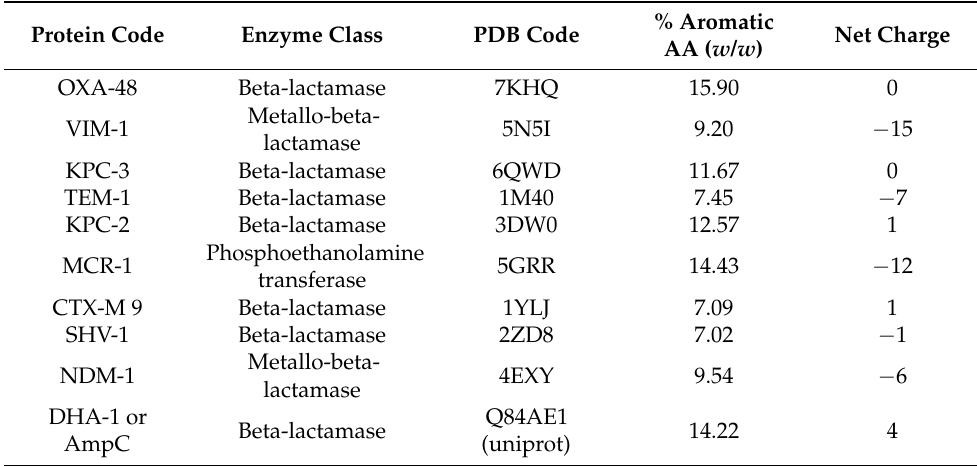
Table 4. Classes, percentages of aromatic amino acids, and net charges of the resistance enzymes indicated to be expressed by the studied MDR strains of E. coli and K. pneumoniae . Protein Code Enzyme